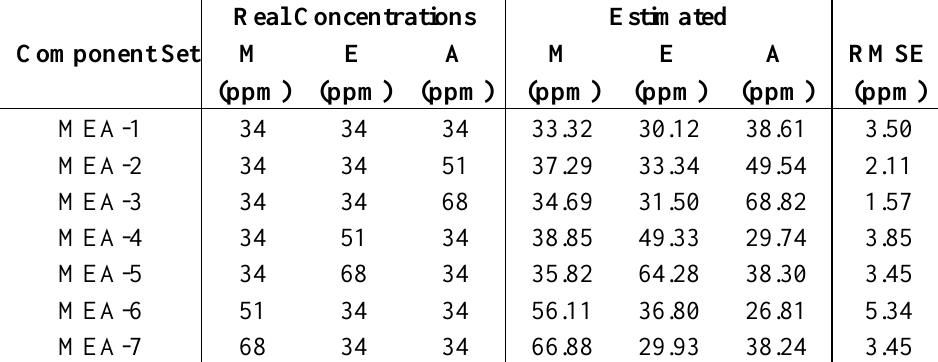
Table 6. The concentration estimation results of the proposed methodology for mixed odors with three components.